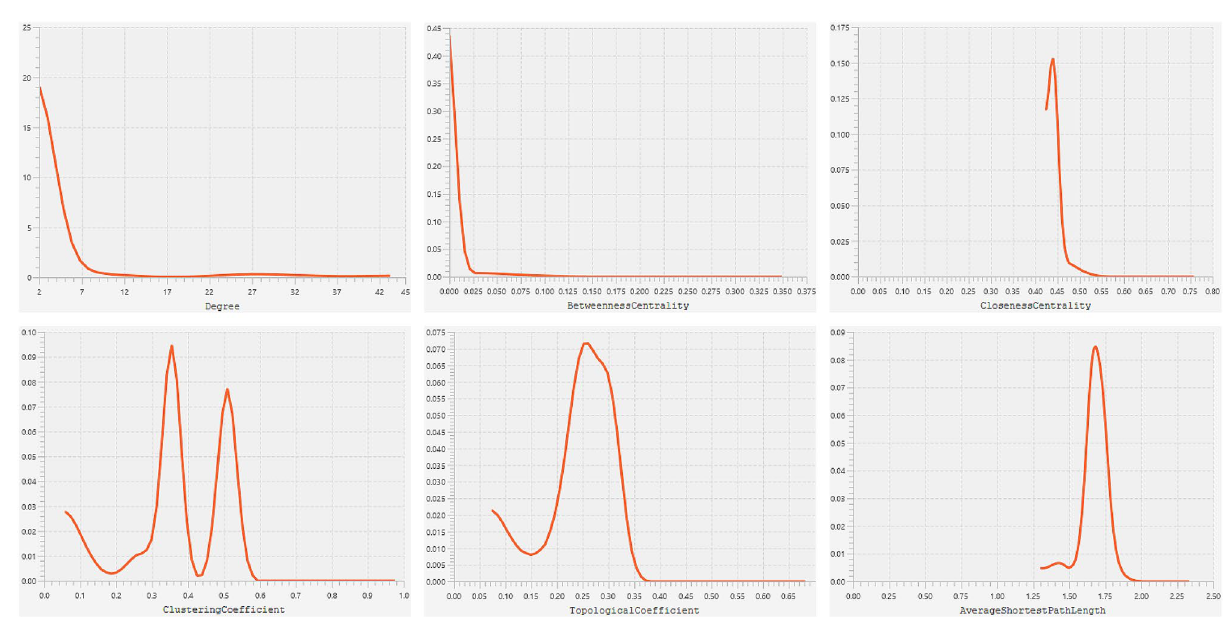
Figure 7. Centrality measures showing node degree distribution, betweenness, closeness, clustering coefficient, topological coefficient, and average shortest path length of miRNA